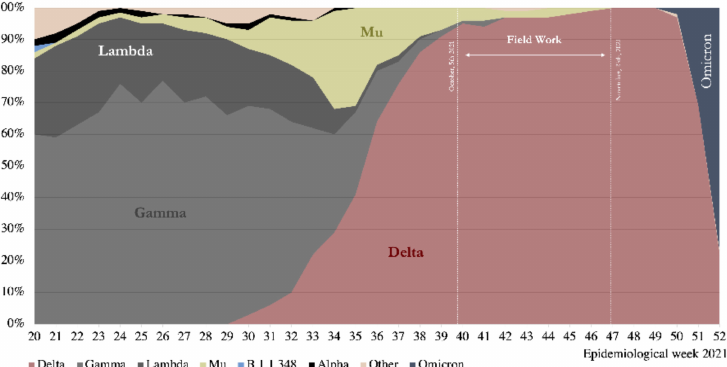
Figure 2. Genomic Surveillance for SARS-CoV-2 Variants of Concern circulating in Chile, 2021. Source: